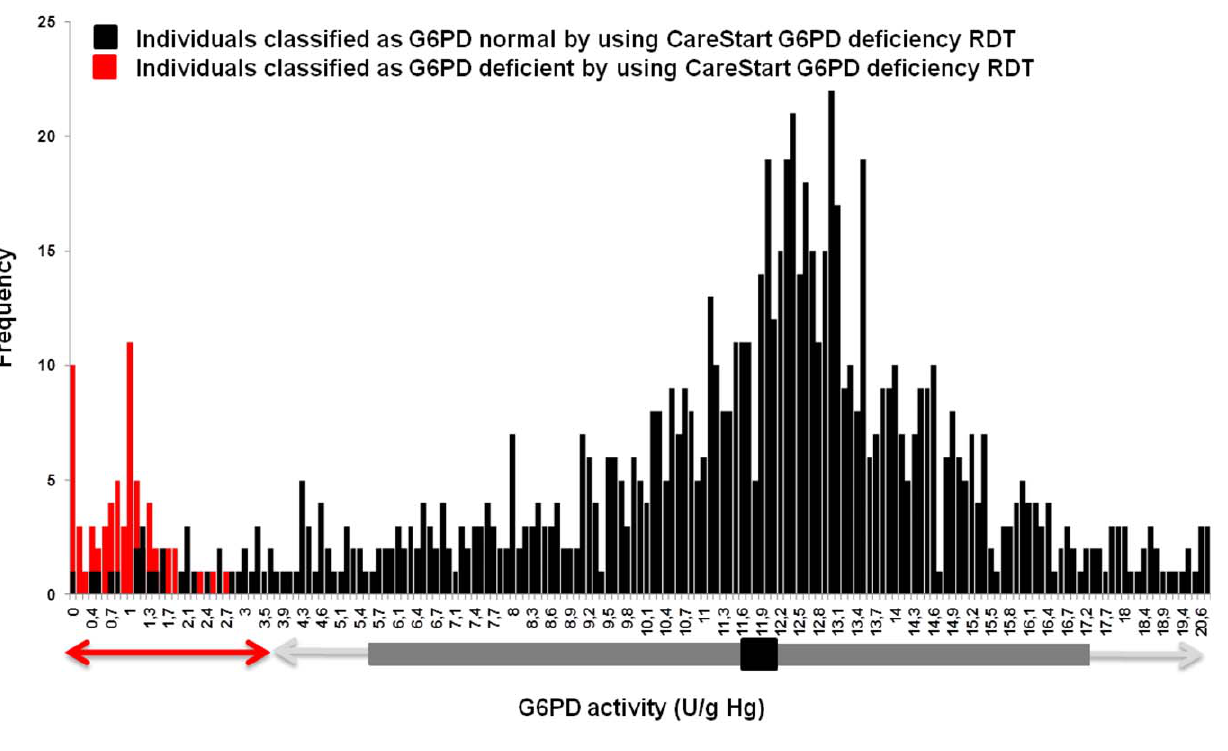
Figure 5. Distribution of the G6PD enzymatic activity (U/g Hb) values, according to the CareStart TM G6PD deficiency screening test results of 903 individuals enrolled in four villages of the Pailin province, Cambodia, 2010.